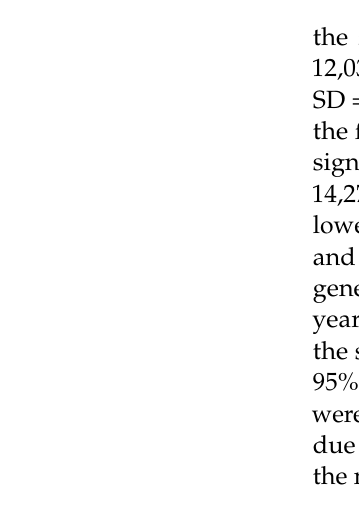
Table 3. Resource use and costs (bootstrapped) for the first year and the second year post-stroke ( n =